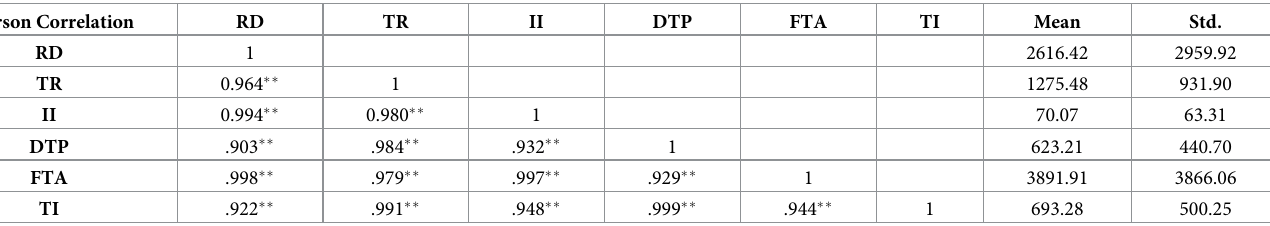
Table 5. Correlation analysis for six technology